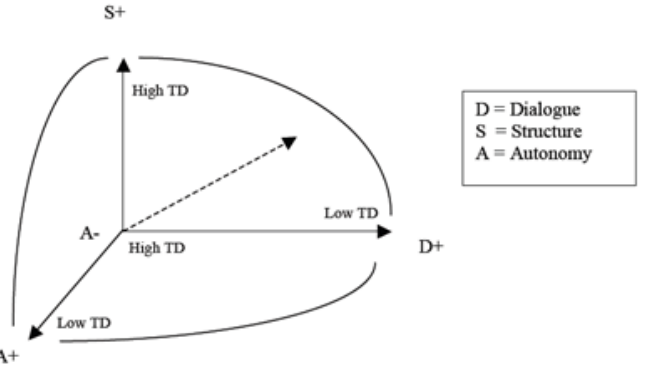
Figure 2. Three dimensions of transactional distance (Adpated from Shearer, 2009, p.